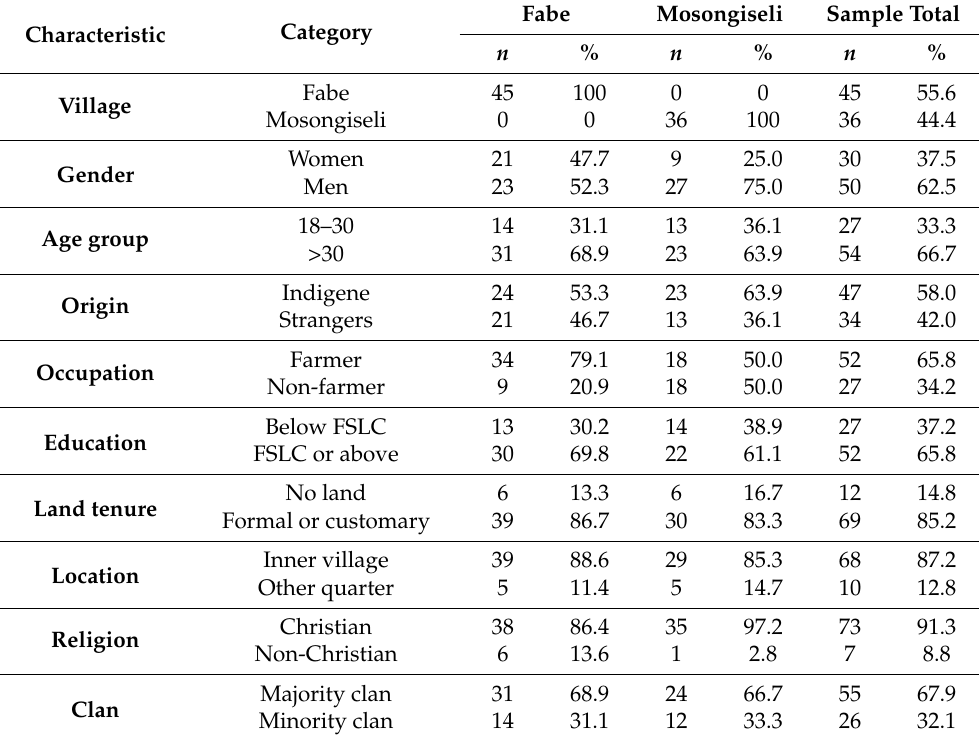
Table 4. Proportions for dichotomous consolidation of demographic variables 1